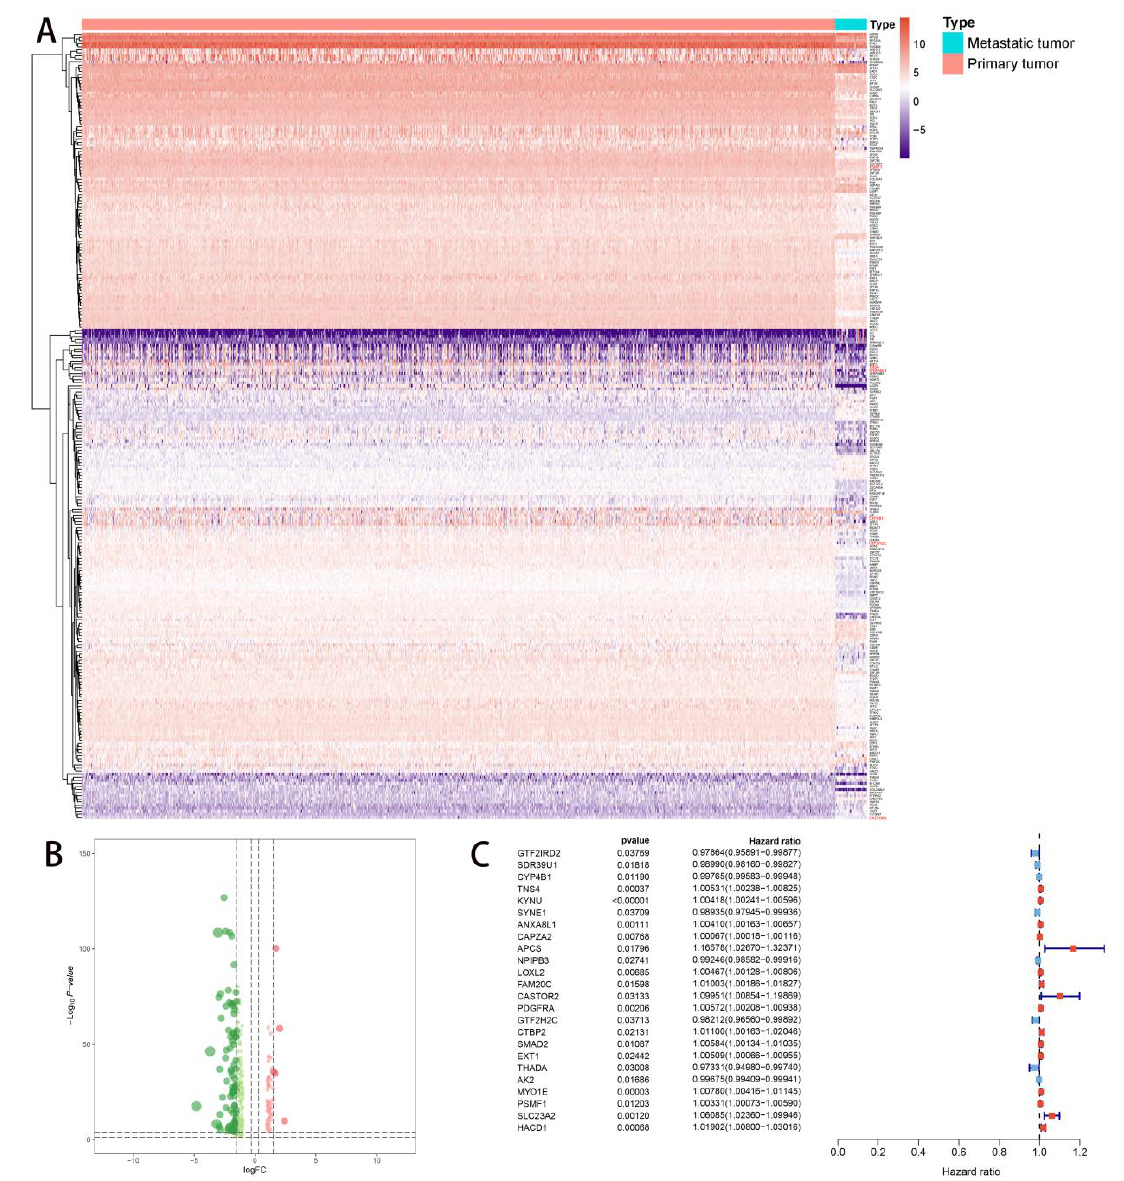
Figure 2. The DEEs identification and DEEs univariate Cox regression analysis. ( A , B ) The identification of DEEs. A total of 255 DEEs (59 upregulated DEEs and 196 downregulated DEEs) were identified between primary NSCLC and metastatic NSCLC. In the heatmap ( A ), red color represented primary NSCLC and blue color represented metastatic NSCLC. In the volcano plot ( B ), red dot represented upregulated DEEs and green dot represented downregulated DEEs, the two dashed horizontal lines mark the positions of p -value = 0.05 and p -value = 0.0001, respectively, and the four vertical dotted lines mark the positions of log2 foldchange (logFC) = −1 .5, logFC = −0 .3, logFC = 0.3 and logFC = 1.5, respectively. ( C ) DEEs univariate Cox regression analysis. Twenty-four eRNAs were identified as PDEEs ( p < 0.05). DEEs, differentially expressed eRNAs; NSCLC, Non-small cell lung cancer; PDEEs, prognostic differentially expressed eRNAs; eRNAs, enhancer RNAs.